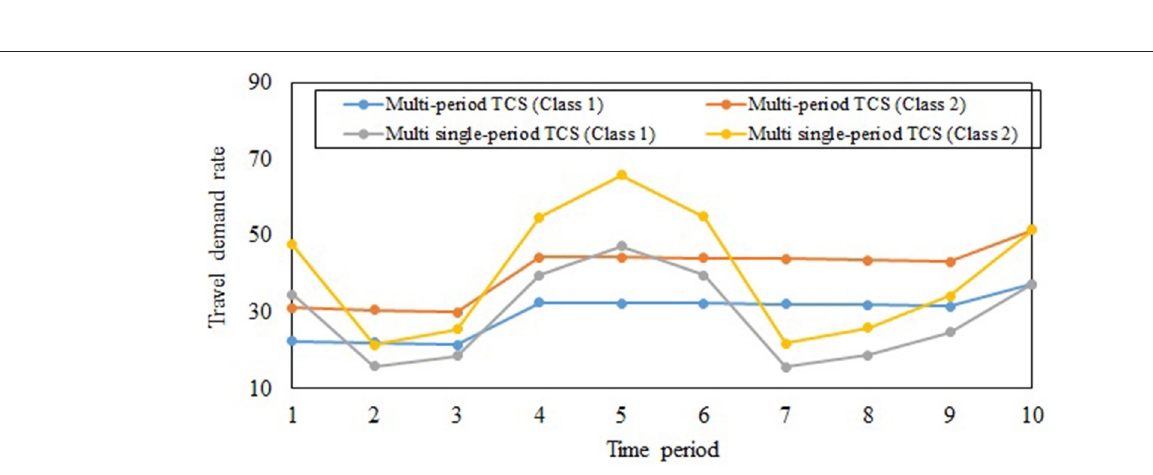
FIGURE 2 | Equilibrium credit prices under the multi single-period TCS and multi-period TCS.